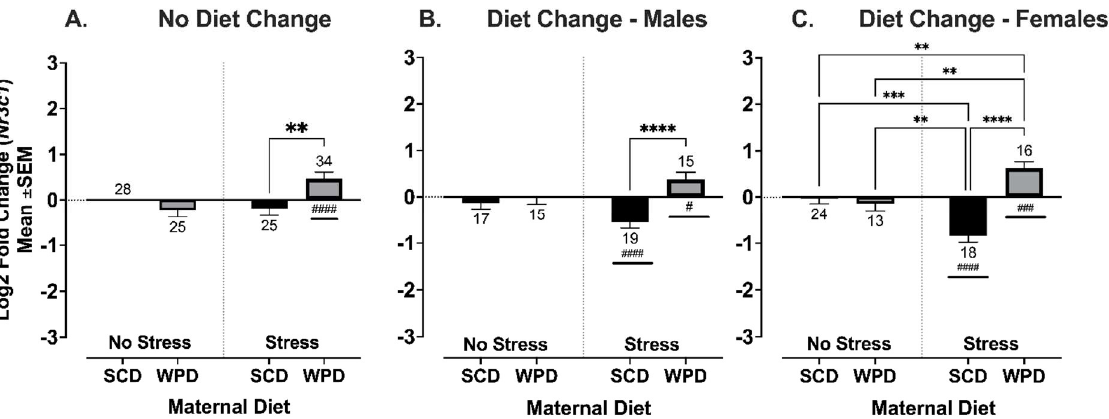
Figure 10. Log2 fold change of hippocampal glucocorticoid receptor, Nr3c1 , compared to no stress/SCD fed controls. Group n ’s located above/below bars. WPD = Western pattern diet, SCD = standard chow diet. ** p < 0.01, *** p < 0.001, **** p < 0.0001. #: significant fold change relative to control., # p < 0.01, ### p < 0.001, #### p < 0.0001.